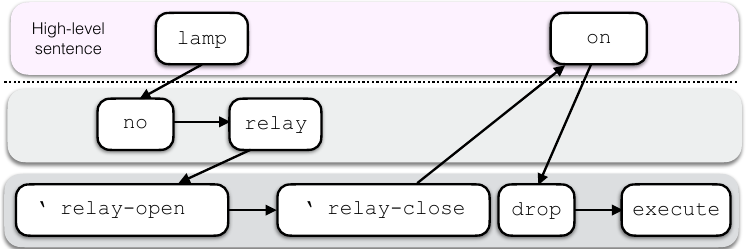
Figure 2. High-level words define a sentence, which can be executed and verified on the target machine. Words are defined in terms of lower-level words. Execution proceeds along the chain of